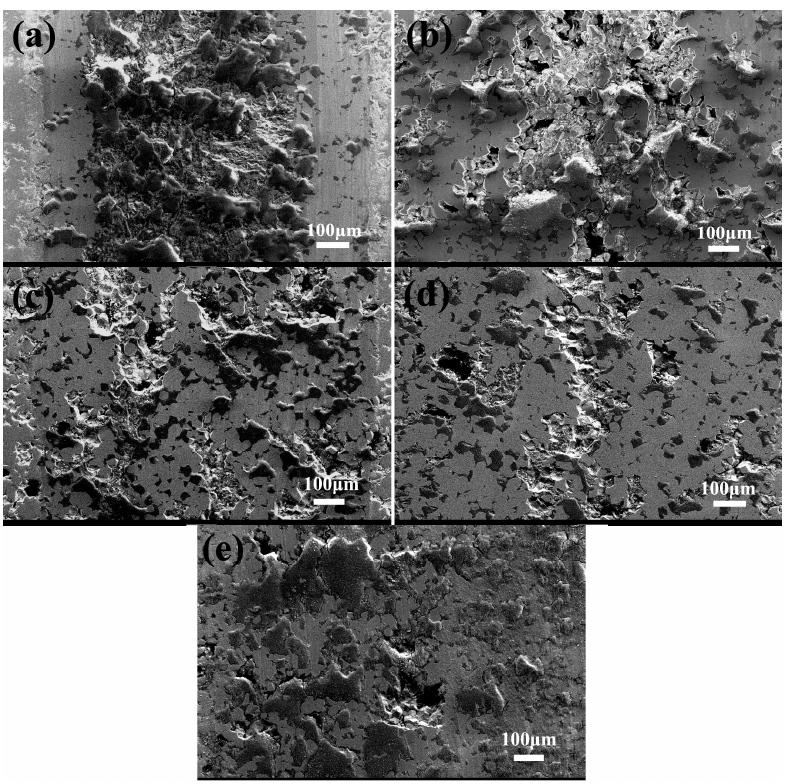
Figure 5. SEM images from wear tracks of ( a ) BMG; ( b ) BMG-1 wt % graphite; ( c ) BMG-2 wt % graphite; ( d ) BMG-3 wt % graphite; (e) BMG-4 wt % graphite composites.